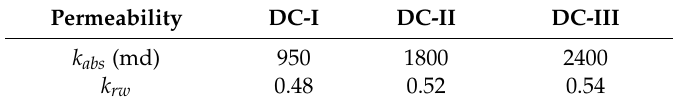
Table 3. Initial sand-pack permeability and relative permeability (water) at residual oil